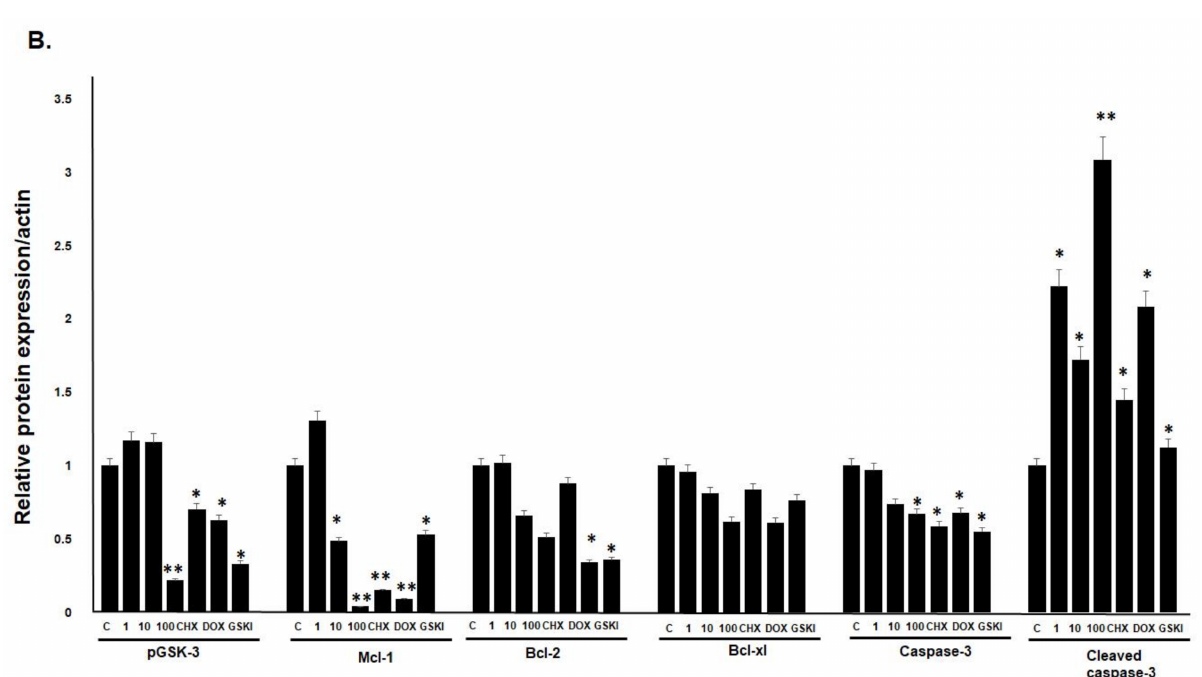
Figure 5. The effects of nordentatin on proteins involved in cell development and apoptosis. ( A ) SH- SY5Y cells were treated with various concentrations of nordentatin, cycloheximide, and doxorubicin for 4 h and compared with the GSK-3 inhibitor. Cell lysates were separated by SDS-PAGE and detected by western blotting using anti-pGSK-3, Mcl-1, Bcl-2, Bcl-xl caspase-3, cleaved caspase-3, and β -actin antibodies. ( B ) Relative phospho-GSK-3, Mcl-1, Bcl-2, Bcl-xl, caspase-3, and cleaved caspase-3 were normalized to that of β -actin, respectively. The experiments were conducted in triplicate. * p < 0.05, ** p < 0.01 versus control